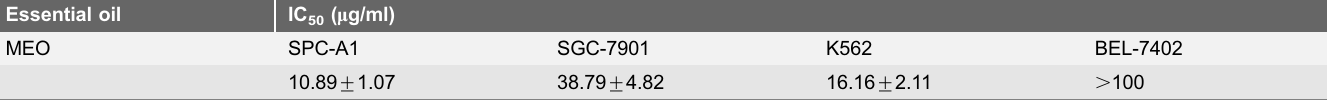
Table 2. Cytotoxic activities of MEO against four human tumor cell lines. Essential oil